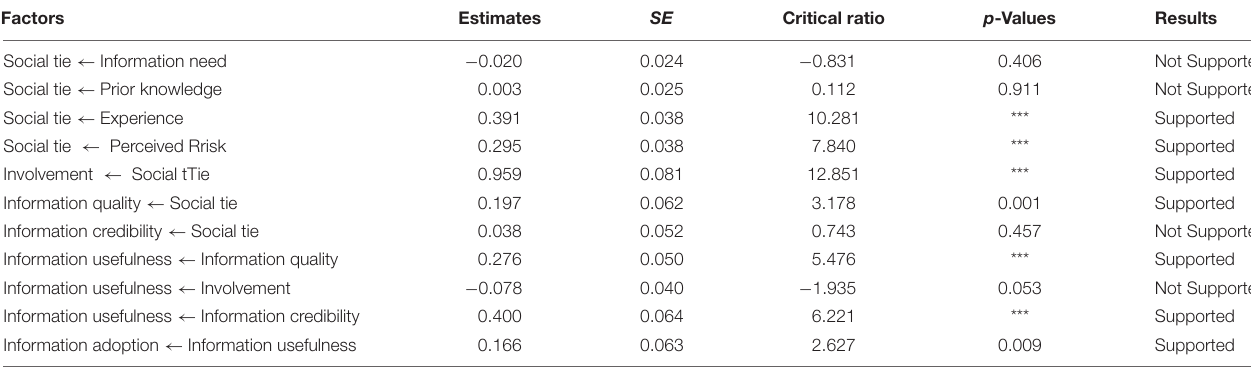
TABLE 5 | The regression weights of casual paths ( n =